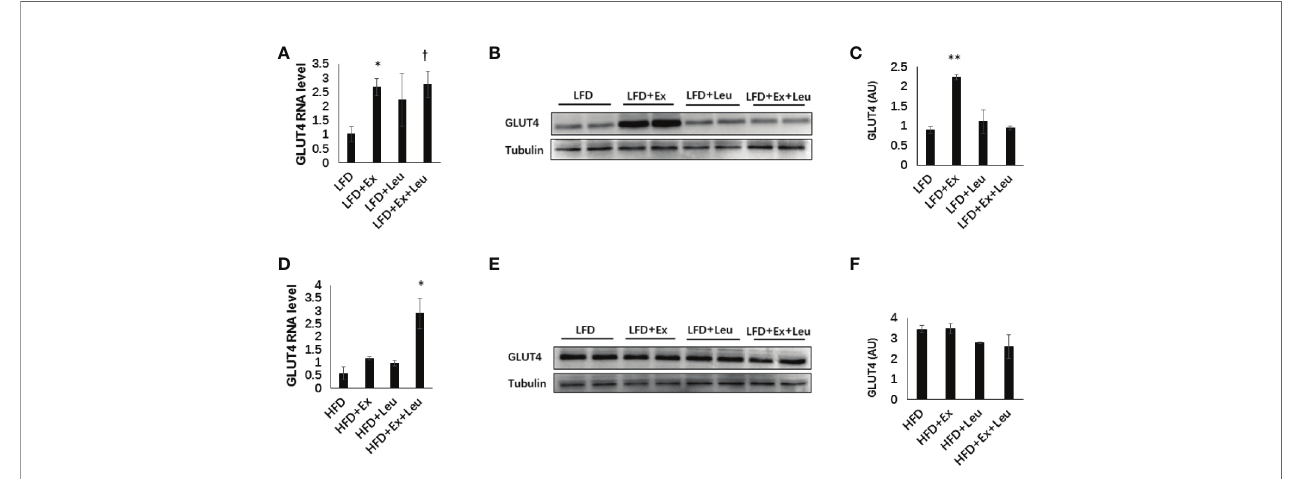
FIGURE 6 | Exercise increased the level of GLUT4 in muscle under LFD. C57BL/6J male mice of 5 – 6 weeks were fed with LFD or HFD. Leucine with a concentration of 1.5% and/or moderate intensity exercise was added in the 10th week and administrated for 4 weeks. (A) Changes in muscle mRNA level of GLUT4 under LFD using RT-PCR. (B) The levels of GLUT4 were determined using western blots. (C) Quanti fi cation of GLUT4 expression (arbitrary units) for (B) . The data are mean ± s.d. (error bars), n = 6 mice per group. *p < 0.05, **p < 0.01, LFD versus LFD + Ex; † , P < 0.05, LFD versus LFD + Ex + Leu. (D) Changes in muscle mRNA level of GLUT4 under HFD using RT-PCR. (E) The levels of GLUT4 were determined using western blots. (F) Quanti fi cation of GLUT4 expression (arbitrary units) for (E) . The data are mean ± s.d. (error bars), n = 4 – 6 mice per group. *p < 0.05, HFD versus HFD + Ex +